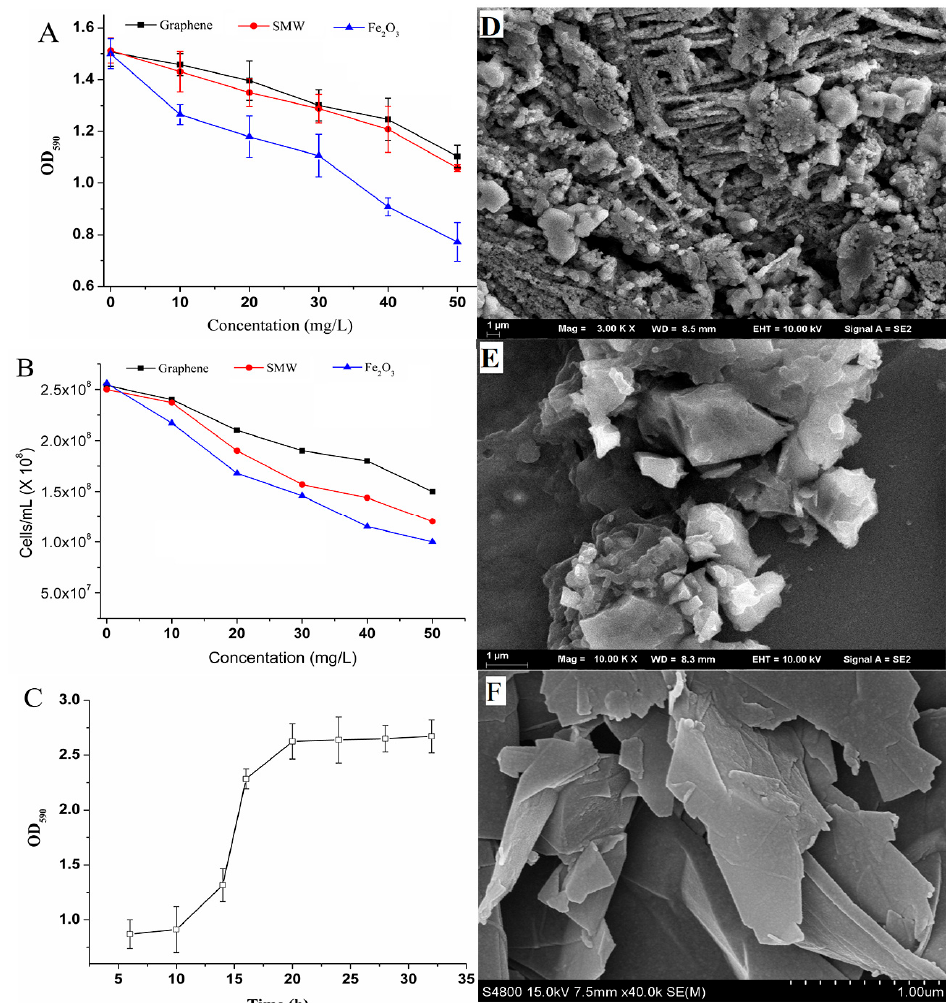
Figure 4. Effects of different nanomaterials and concentrations on growth of biofilms ( A ) and recombinant E. coli BL21-pET28a- egfp ( B ). The growth of recombinant E. coli biofilms with graphene nanomaterial was measured under segment flow mode ( C ). The SEM patterns of biofilms formed in microchannels with LB medium ( D ), LB medium containing graphene sheets (10 mg/L) ( E ), and graphene sheets ( F ).